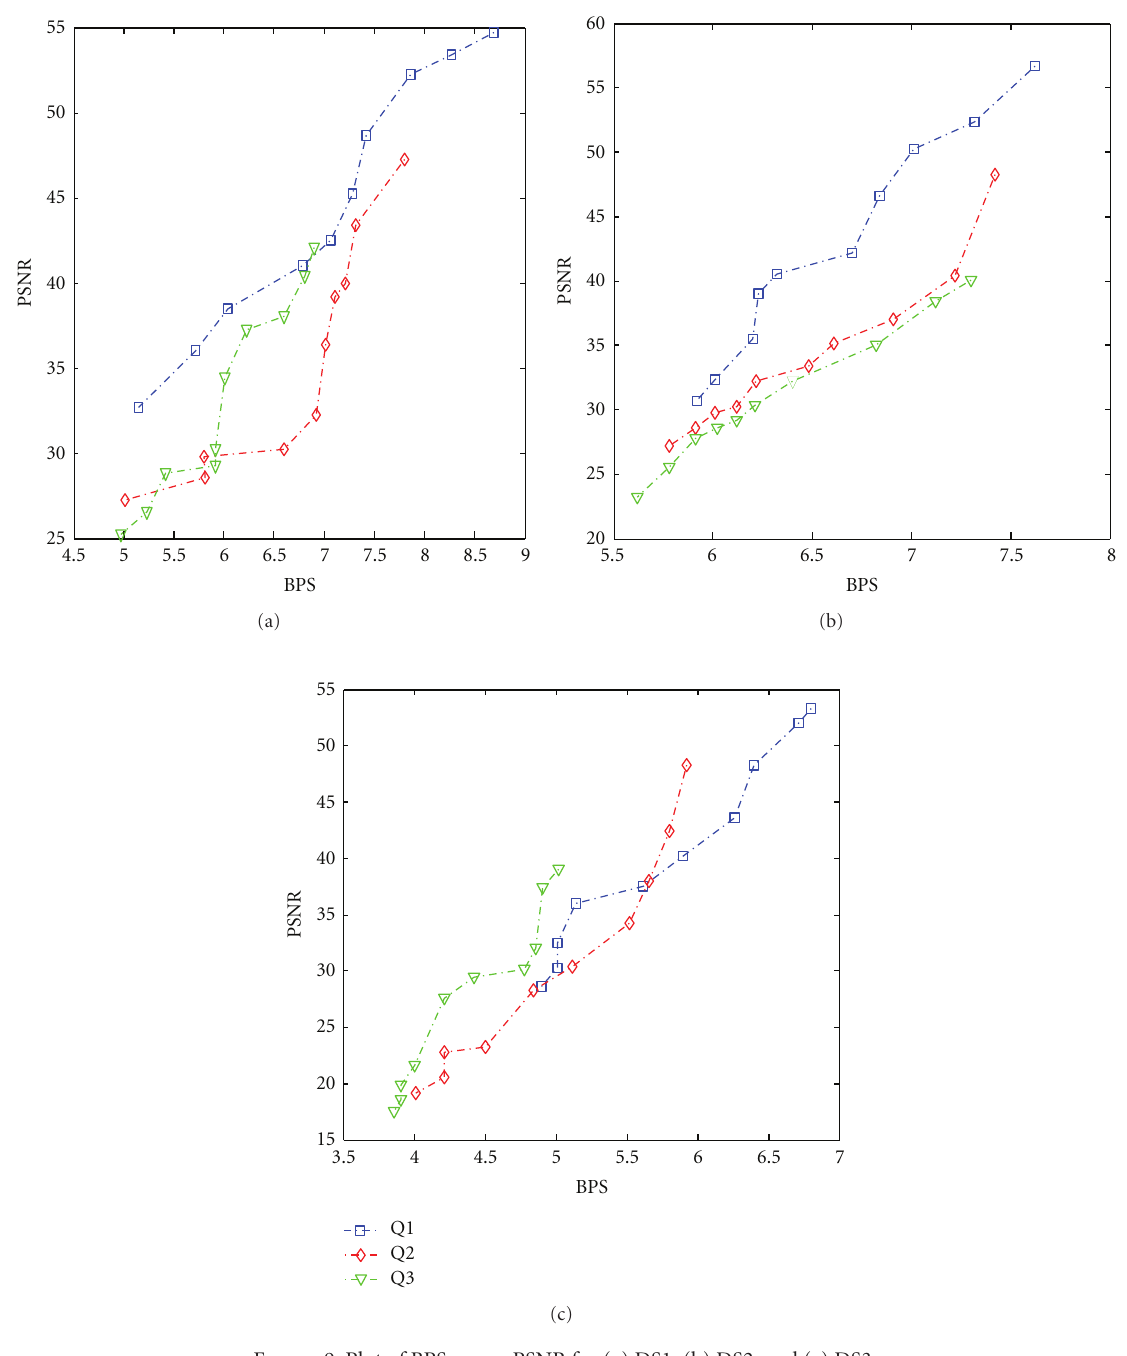
Figure 9: Plot of BPS versus PSNR for (a) DS1, (b) DS2, and (c)